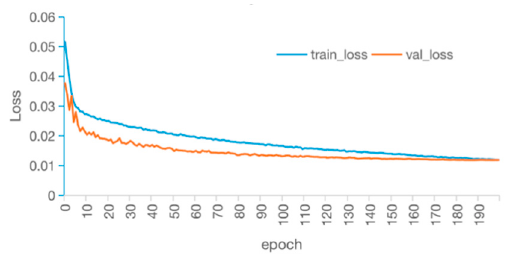
Figure 8. Change curve of loss value.